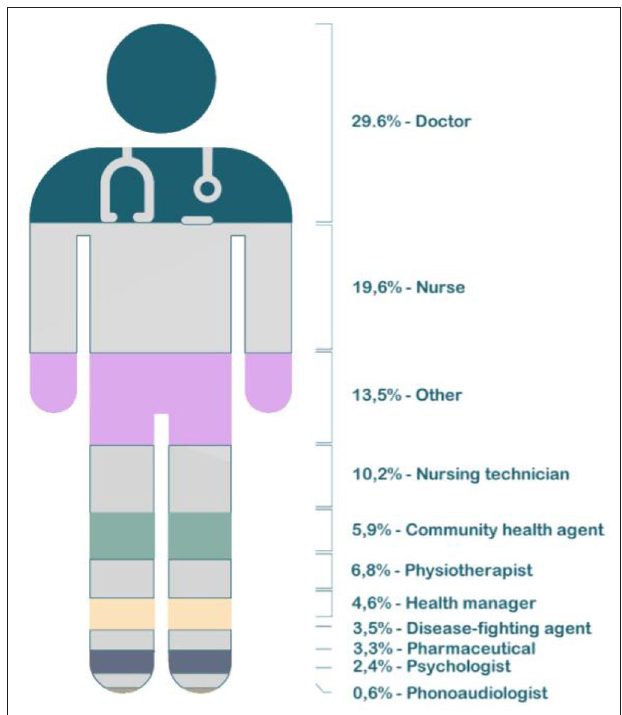
FIGURE 2 | Participants by professional activity.